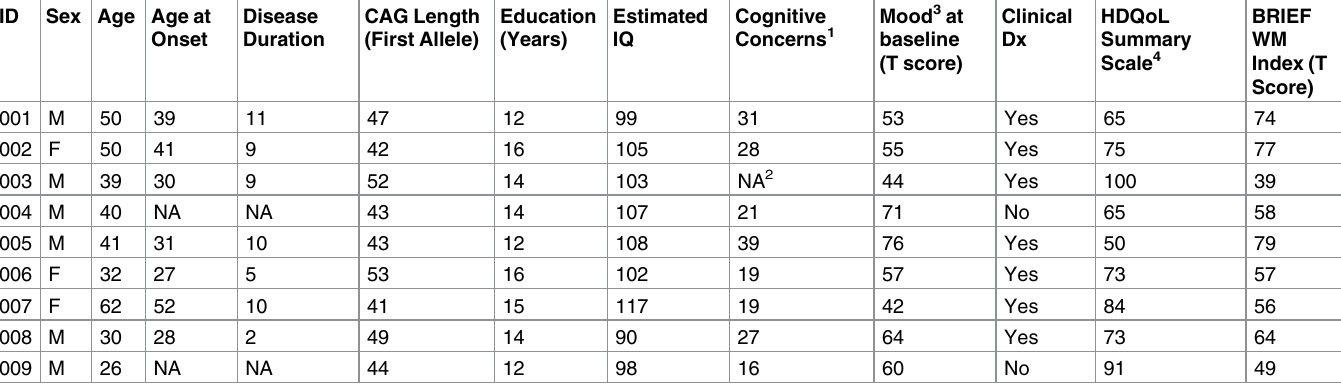
Table 2. Demographic and clinical characteristics for all participants (N = 9). ID Sex Age Age at Disease Onset